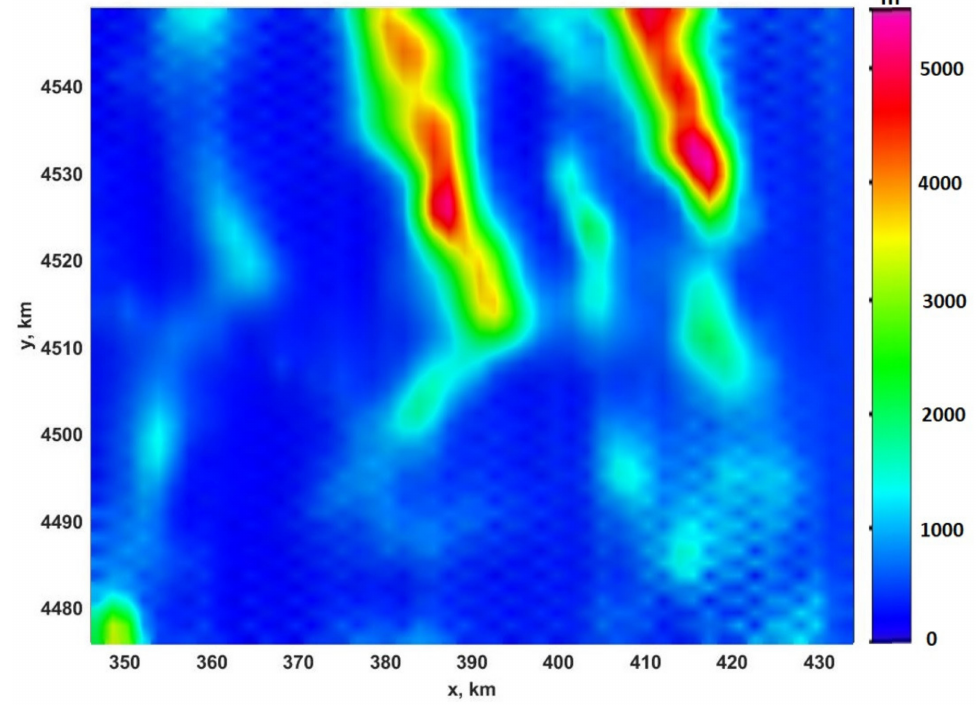
Figure 5. Map of the density contrast surface produced by the depth-to-basement